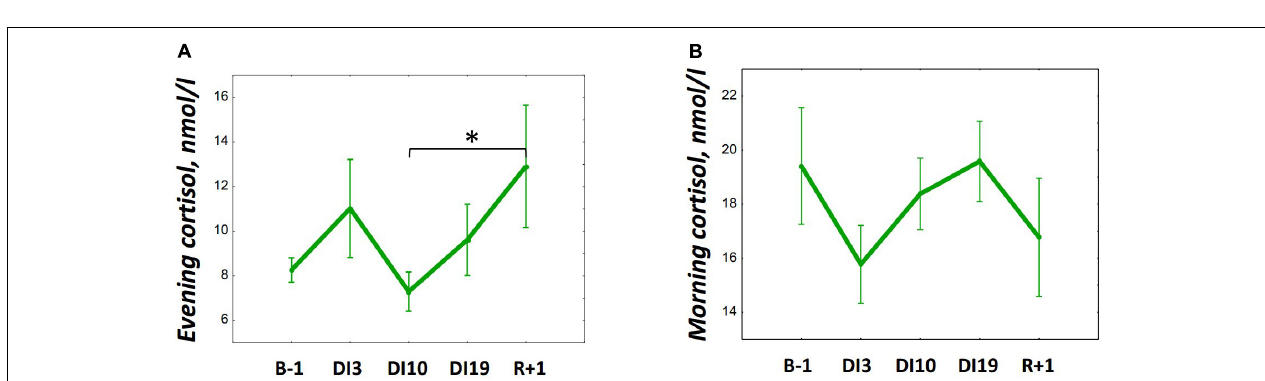
FIGURE 2 | Changes in the subjective pain intensity (in points) and pain localization during 21-day Dry Immersion (DI). BDC, averaged values obtained during 7 days before DI starts; DI1, averaged values obtained on the 1st day of DI; DI2, averaged values obtained on the 2nd day of DI, etc.; R + 0, values obtained 2 h after the end of DI; R + 1, values obtained 24 h after the end of DI, etc.